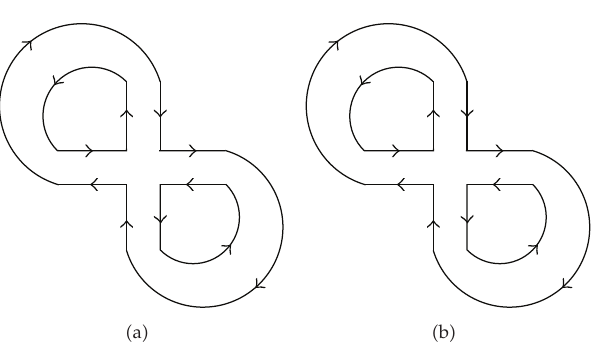
Figure 8: Disconnected diagram contributing to the correlation function (cid:12) Tr (cid:2)Φ 4 (cid:3) Tr (cid:2)Φ 4 (cid:3) (cid:13) . Created by Brian Swingle.